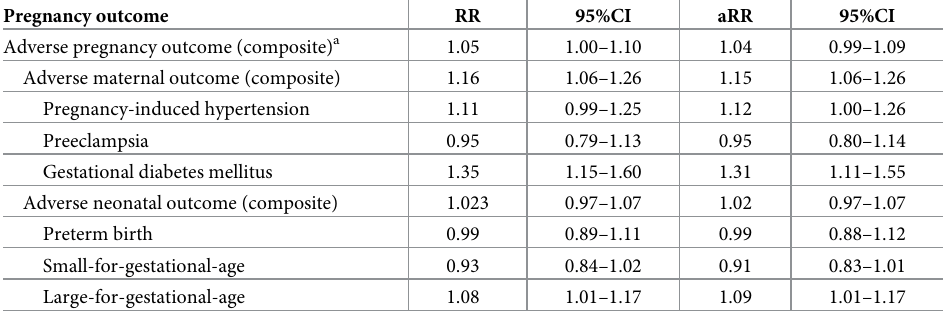
Table 4. Associations between maternal prepregnancy BMI as a continuous variable and adverse pregnancy out- comes in a subpopulation of women with a BMI within the reference interval (18.5–24.9 kg/m 2 ). Pregnancy outcome Adverse pregnancy outcome (composite) a Adverse maternal outcome (composite) Preeclampsia Adverse neonatal outcome (composite) Small-for-gestational-age Large-for-gestational-age 1.01–1.17 BMI , body mass index; NA, not applicable (no cases). RR , relative risk. 95%CI , 95% confidence interval. aRR , adjusted relative risk (adjusted for age, smoking and educational level).